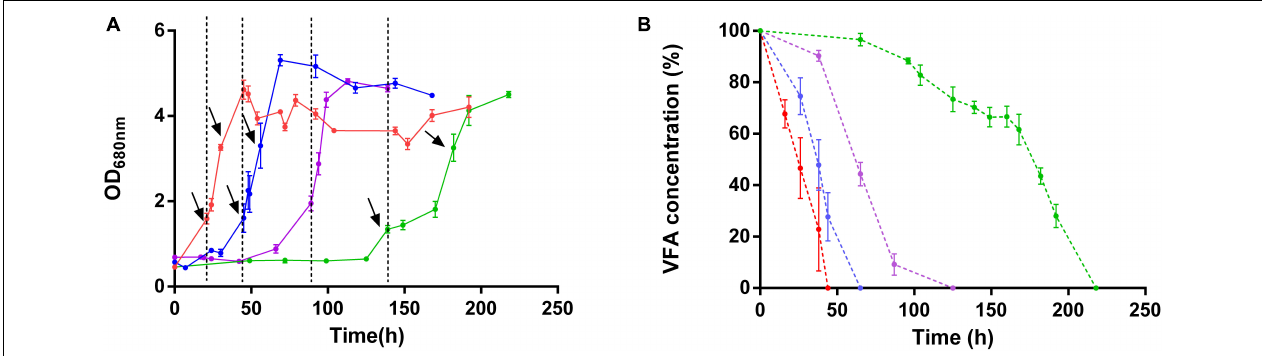
FIGURE 2 | Growth profile (A) and carbon source consumption (B) of wild-type Rs. rubrum in the presence of succinate (red), acetate and 3 mM HCO 3 − (green) or 50 mM HCO 3 − (purple) and the acetate-competent strain (blue). Dotted black lines represent the increase in light intensity from 50 to 150 µ mol of photons/m 2 s. Black arrows represent the sampling time for the sample submitted to the proteomic analysis, n = 5.